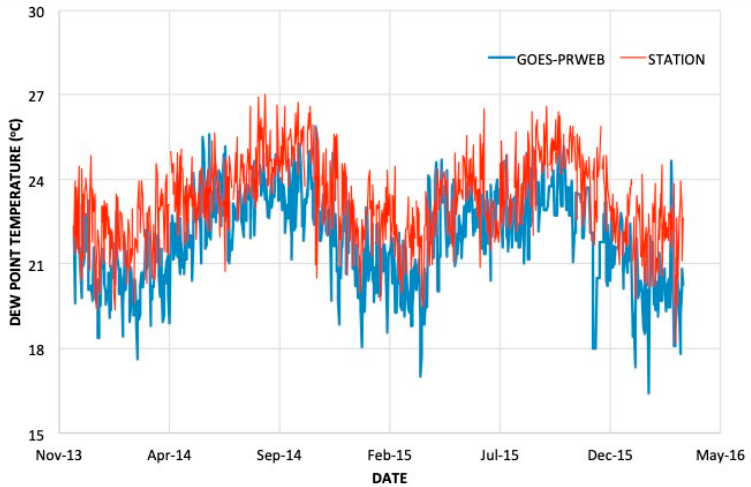
Figure A3. Modeled and observed T d from January 2014 to April 2016 at the UPR Agricultural Experimental Station near Juan Diaz, Puerto Rico.